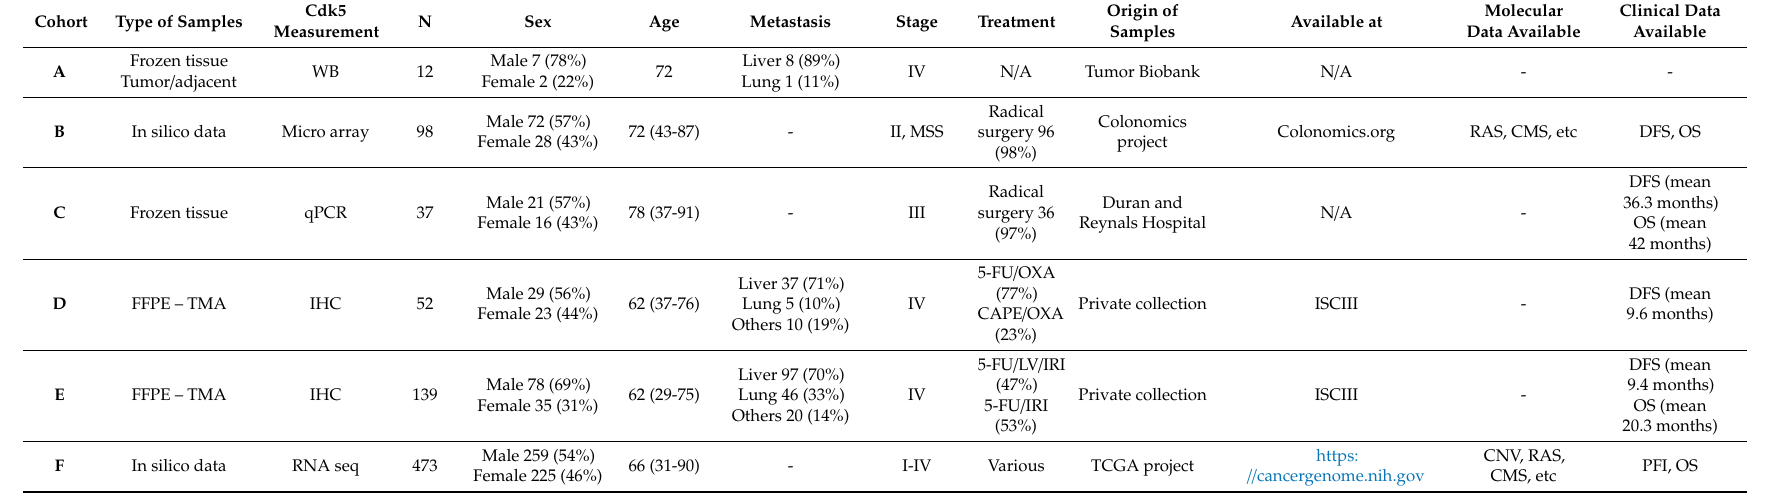
Table 1. Overview of cohort used in the